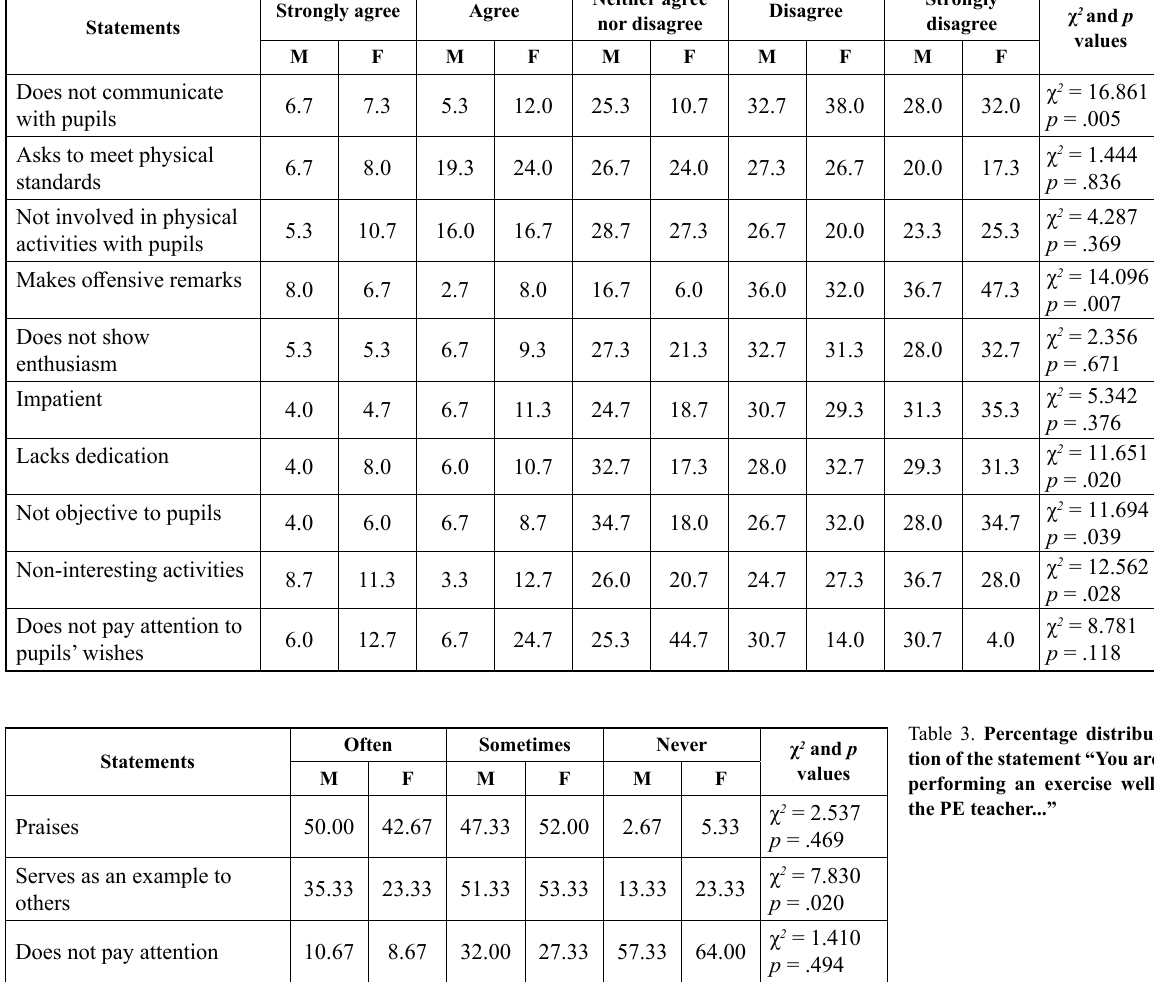
Table 2. Percentage distribution of responses to the question “What traits of the PE teacher characteristics do you